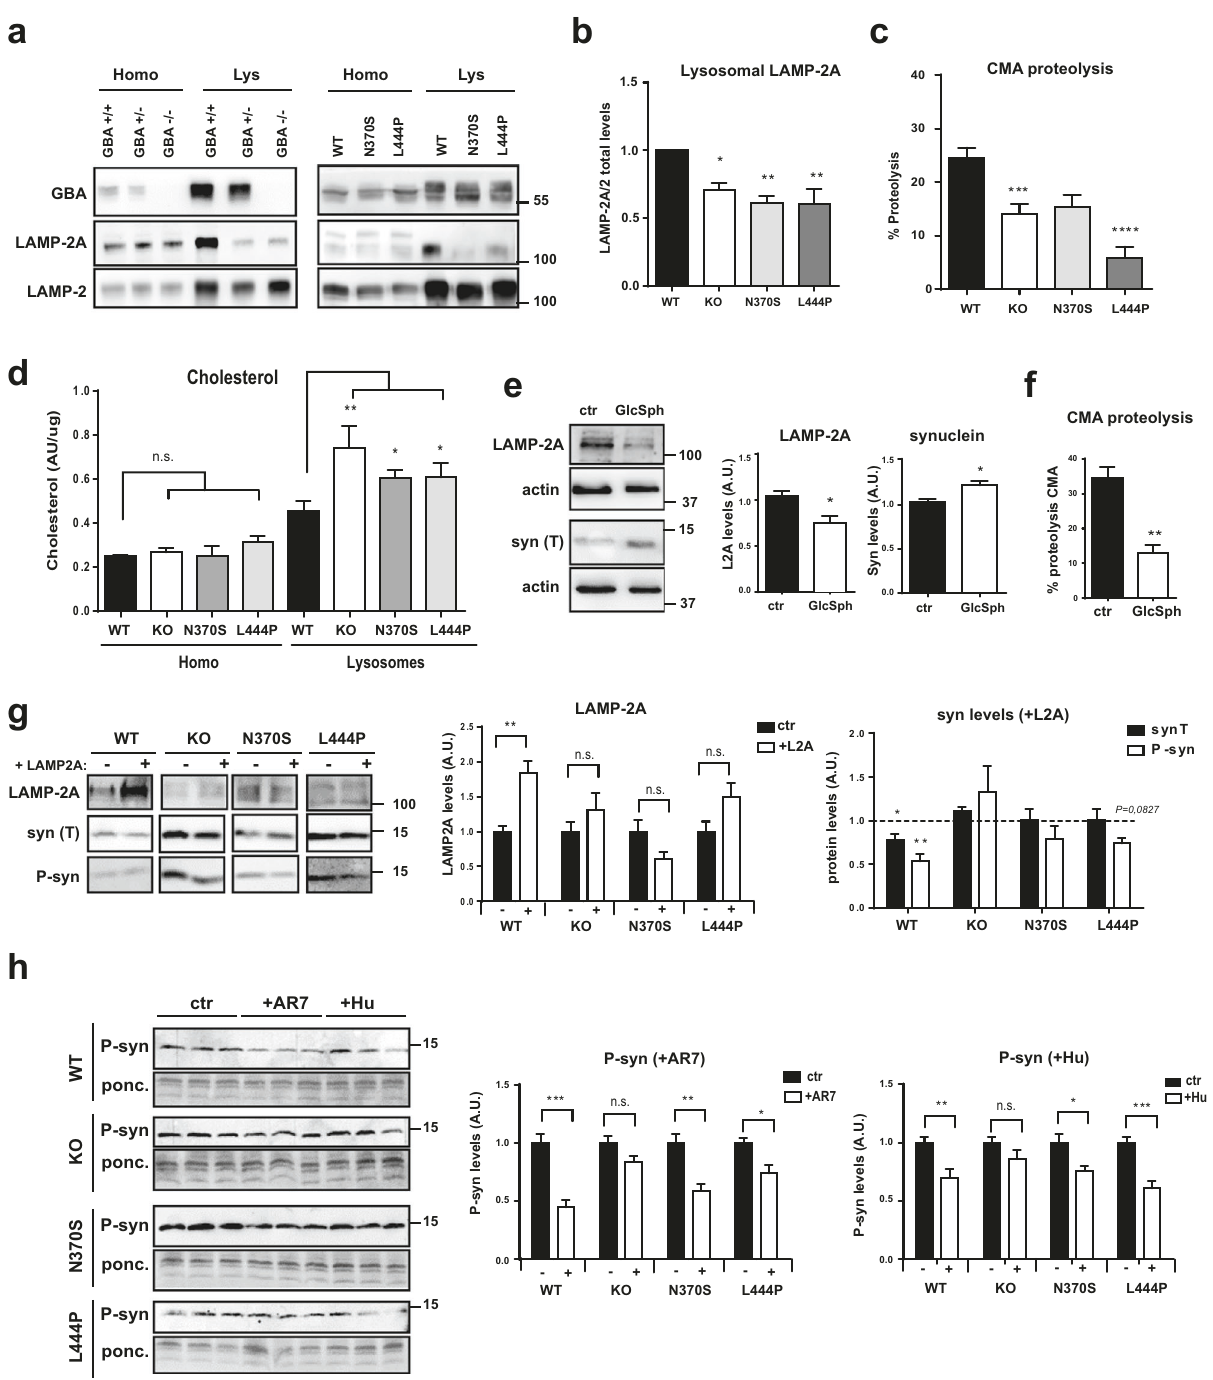
Fig. 6 Mutant GBA is associated with CMA impairment. a Immunodetection of LAMP-2A, total LAMP-2, and GBA in total homogenate (homo) and isolated lysosomes (Lys). b Quanti fi cation of LAMP-2A levels in the lysosomal fraction corrected using total LAMP-2, n = 4 independent isolations. c Proteolysis dependent on CMA detected as 3-MA-insensitive/leupeptin-NH 4 Cl-sensitive proteolytic activity, n > 4 in each group. d Total cholesterol quanti fi cation in homogenate (homo) and isolated lysosomes (Lysosomes) n = 6. e Quanti fi cation of total LAMP-2A and total synuclein levels in GBA WT cell lines after 72 h treatment with 5 mM GlcSph, n = 3. f Proteolysis dependent on CMA detected as 3-MA-insensitive/leupeptin/NH 4 Cl-sensitive proteolytic activity after 72 h treatment with 5 mM GlcSph, n = 3. g Representative images (left) of immunodetection of LAMP-2A and total/phosphorylated synuclein after 48 h of transient transfection. Quanti fi cation (right) of LAMP-2A transfection (LAMP-2A levels in control transfection in each cell line normalized to 1) and total and phosphorylated α -syn after transfection (syn protein levels in control transfection in each cell line normalized to 1), values of three independent experiments. h Immunodetection of phosphorylated synuclein (P-syn) and ponceau (ponc) as a loading control after 24 h treatment with AR7 and humanin (Hu) (left), and quanti fi cation of P-syn levels (left) [P-syn levels in cells treated with vehicle (ctr) in each cell line are normalized to 1]; values of six independent samples. In all panels, results are presented as mean ± s.e.m values. Statistical signi fi cance was established at * p < 0.05, ** p < 0.01 after two-way ANOVA followed by Tukey ’ s multiple comparisons tests ( b – d ) or two-tailed unpaired Student ’ s t -test ( e – h